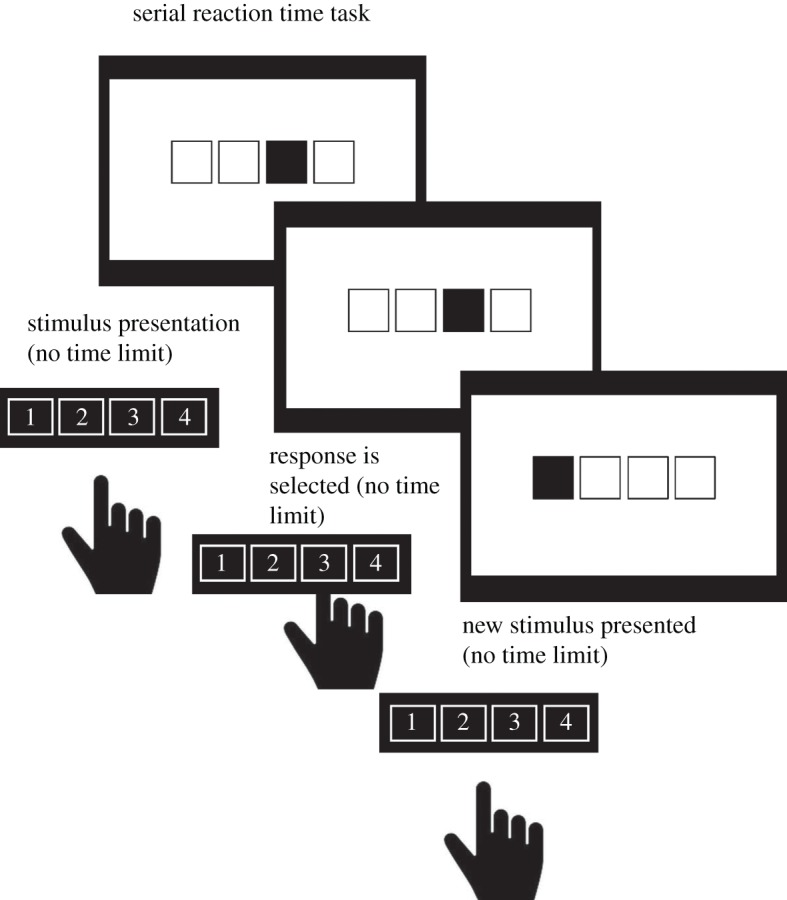
Example of a pre-sleep SRTT session. Participants pressed the key corresponding to the filled square onscreen, with accuracy and reaction times being recorded.